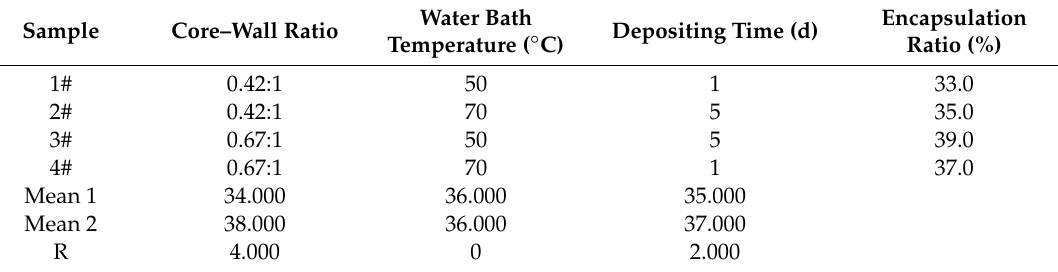
Table 5. Range results of microcapsule encapsulation ratio.